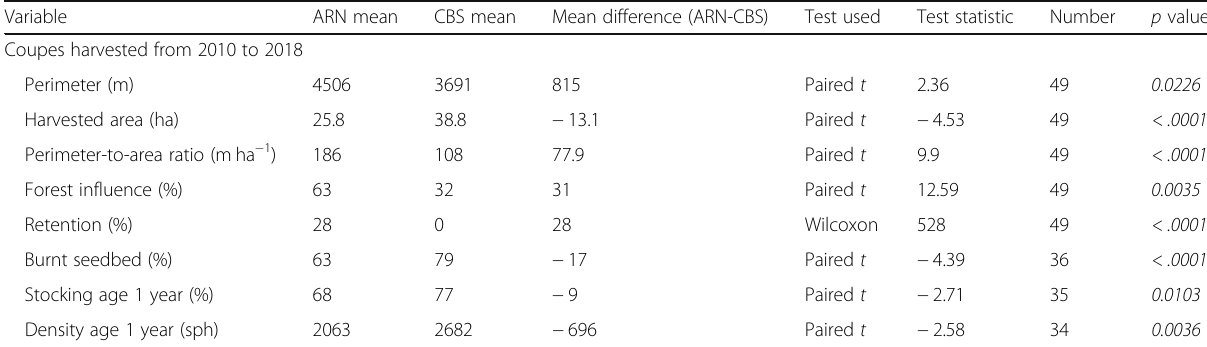
Table 2 Mean differences in selected variables between paired ARN and CBS coupes harvested from 2010 to 2018